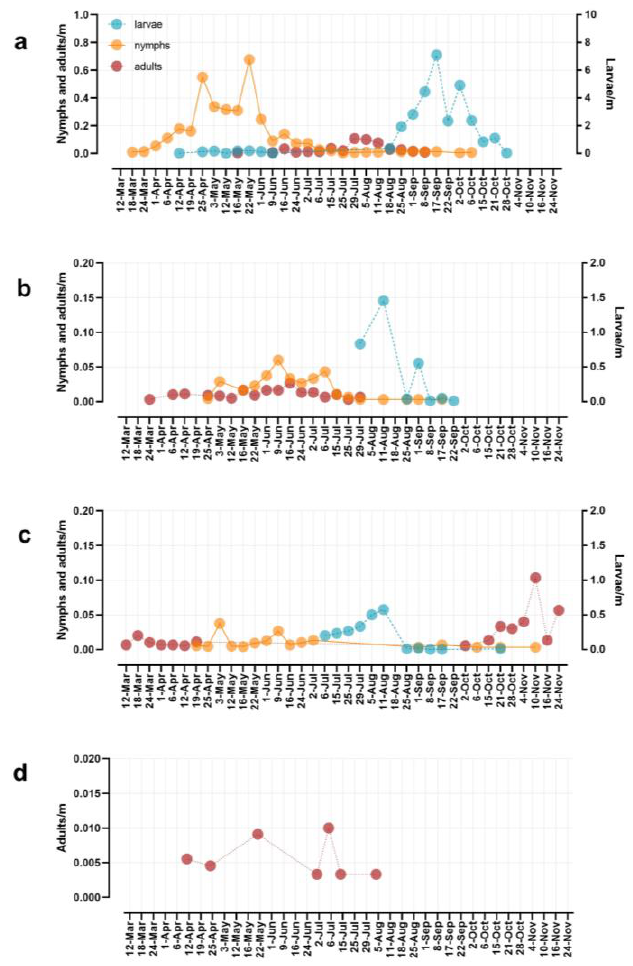
Figure 2. Seasonal dynamic of each life stage and tick species collected. Samplings with zero ticks collected are not represented. ( a ) Haemaphysalis longicornis ; ( b ) Amblyomma americanum ; ( c ) Ixodes scapularis ; ( d ) Dermacentor variabilis . Notice the difference in scale (5× higher) for H. longicornis. Nymphs of H. longicornis were the first stage detected in the ecotone of deciduous forests in Middlesex (NJ) and were present from 18 March to 6 October. Adults were pre-